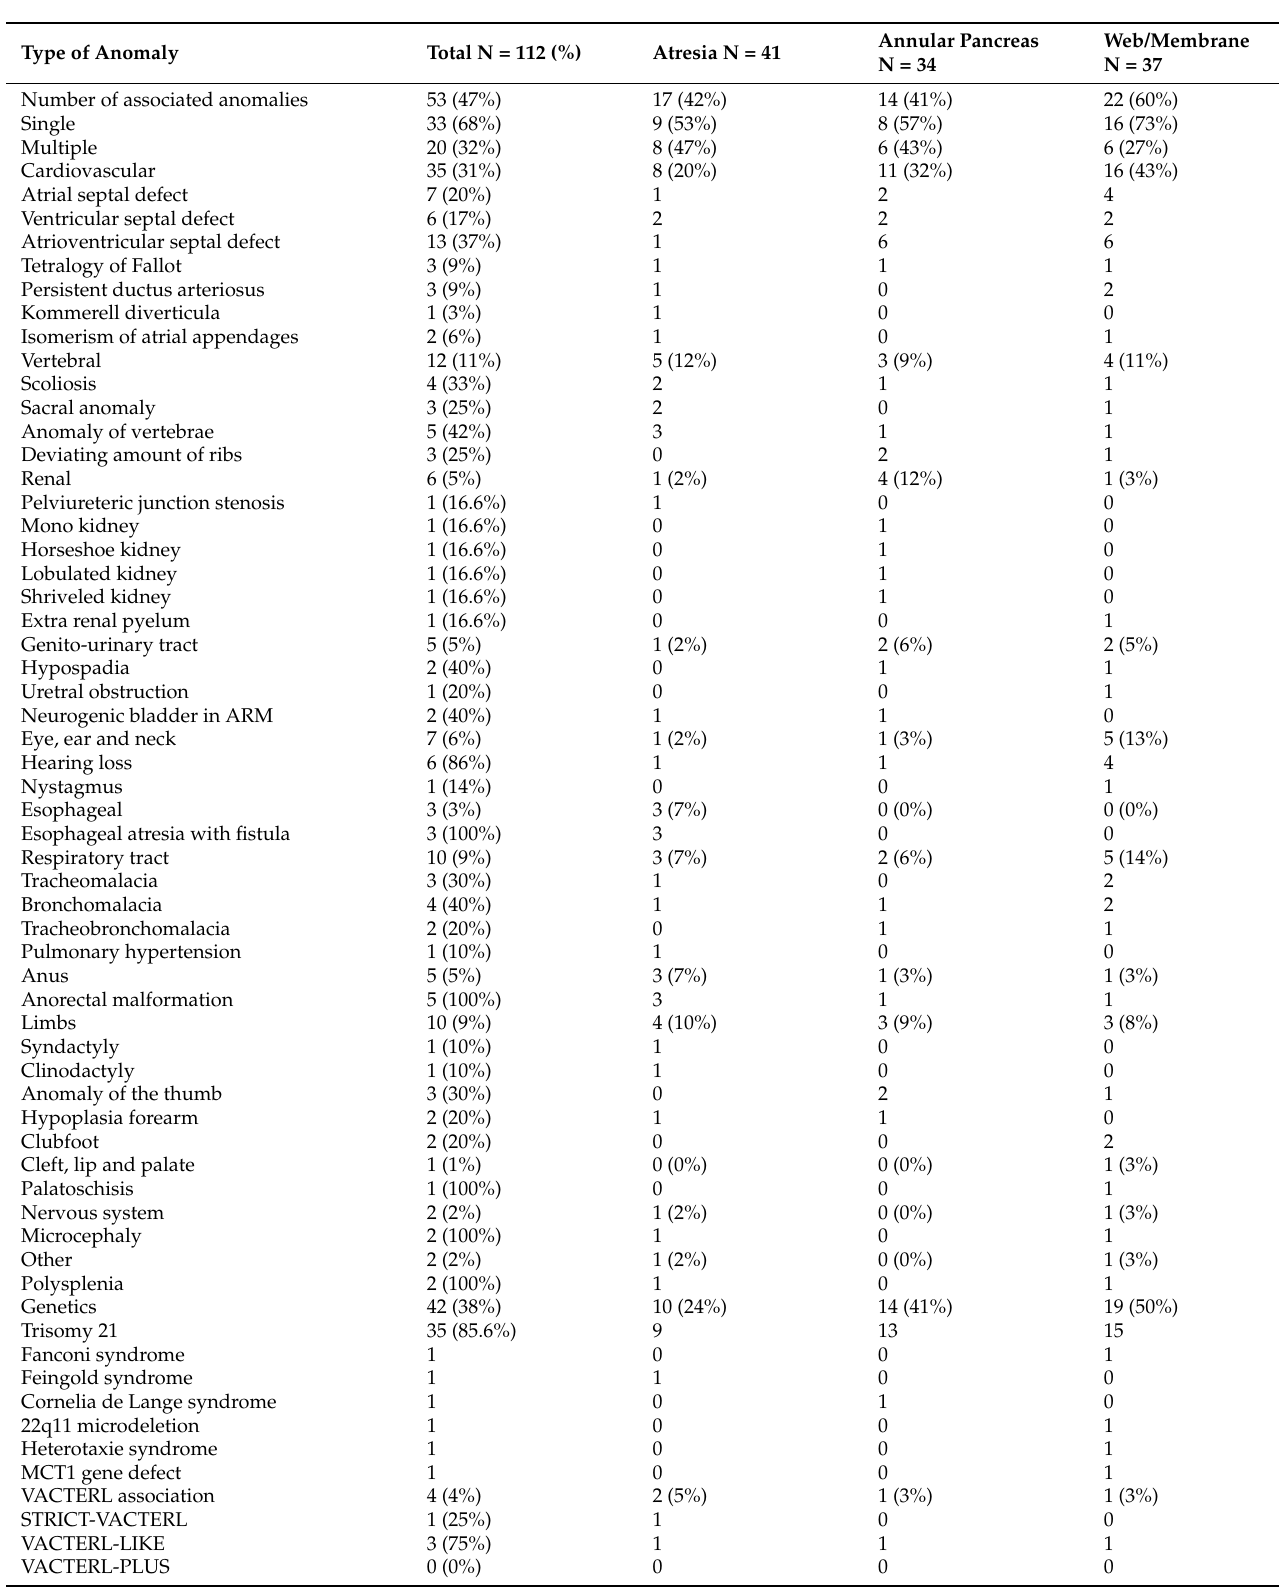
Table 2. Overview of associated